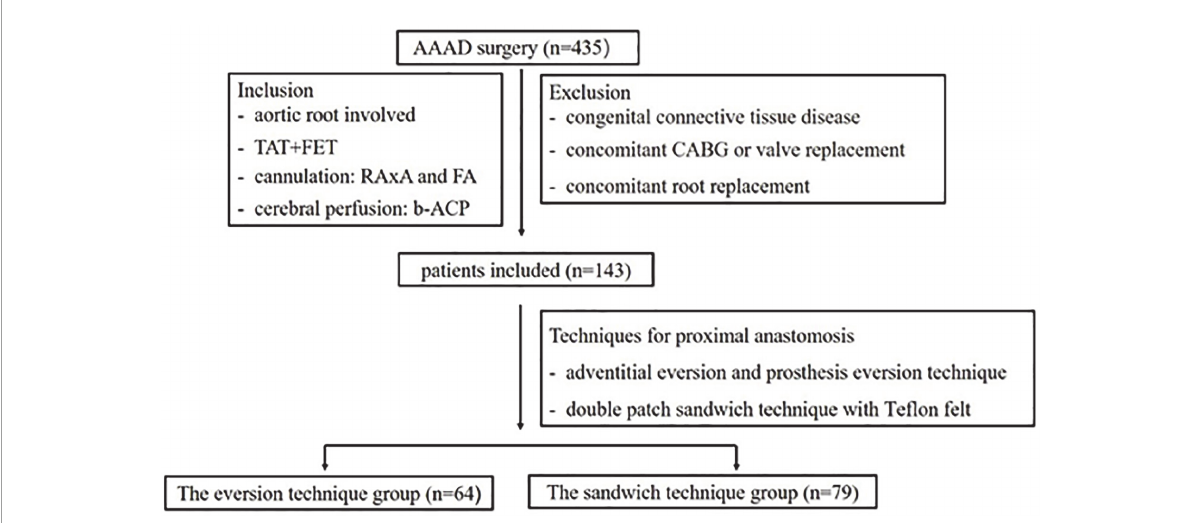
FIGURE1 Schematic of the study cohort. Between December 2017 and May 2021, 435 patients with AAAD underwent surgical repair in our department. 143 patients were included in this study according to the inclusion and exclusion criteria. These patients were divided into two groups according to the repair methods of proximal anastomosis, the eversion technique group (adventitial eversion and prosthesis eversion technique for proximal anastomosis, n = 64) and the sandwich technique group (double patch sandwich technique with Teflon felt for proximal anastomosis, n = 79). AAAD, acute type A aortic dissection; TAT, total arch replacement; TET, frozen elephant trunk; RAA, right axillary artery; FA, femoral artery; b-ACP, bilateral antegrade cerebral perfusion; CABG, coronary artery bypass